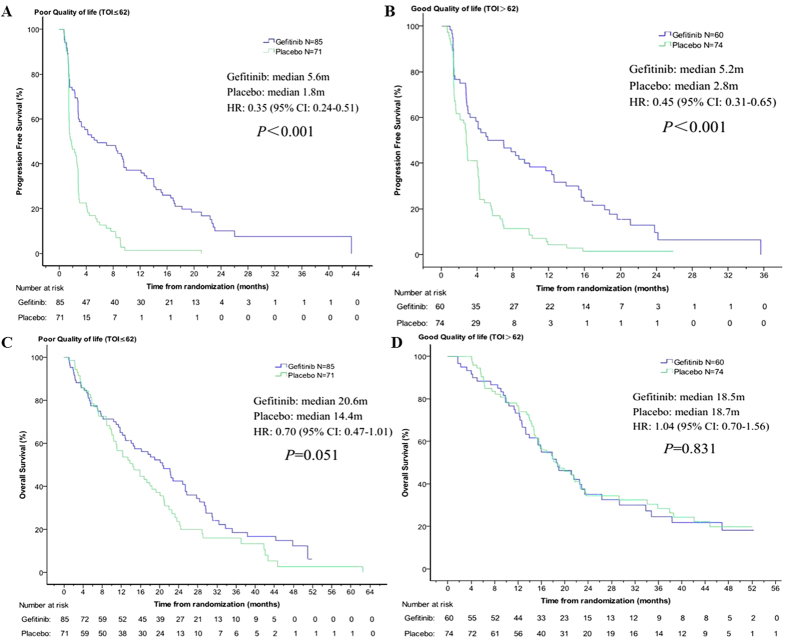
Kaplan-Meier curves for progression-free survival in patients with poor QoL(A) and good QoL (B), and for overall survival in patients with poor QoL (C) and good QoL (D). Patients had been divided into good or poor QoL group according to the score of TOI at baseline (good: TOI > 62; poor: TOI ≤ 62). Cox proportional hazards regression model were used to estimate hazard ratio (HR). HR < 1 implied a lower risk of progression or death with gefitinib than with placebo.